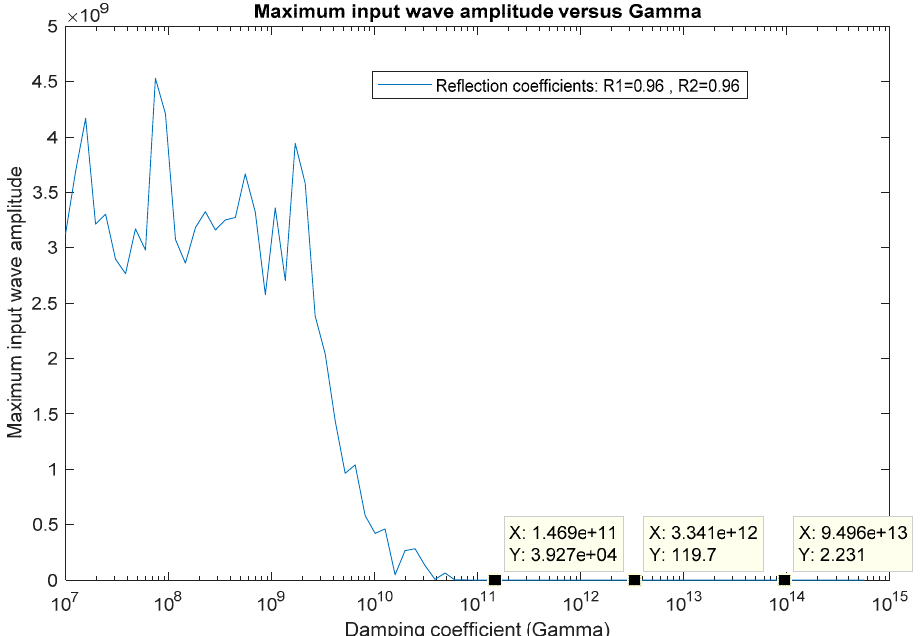
Figure 16. Maximum input wave amplitude at x = 5.73 μ m versus the damping coefficient gamma ( 𝛾 ).